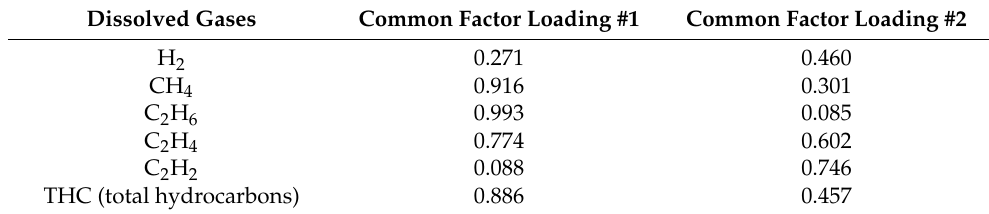
Table 1. Common factor loading of DGA.